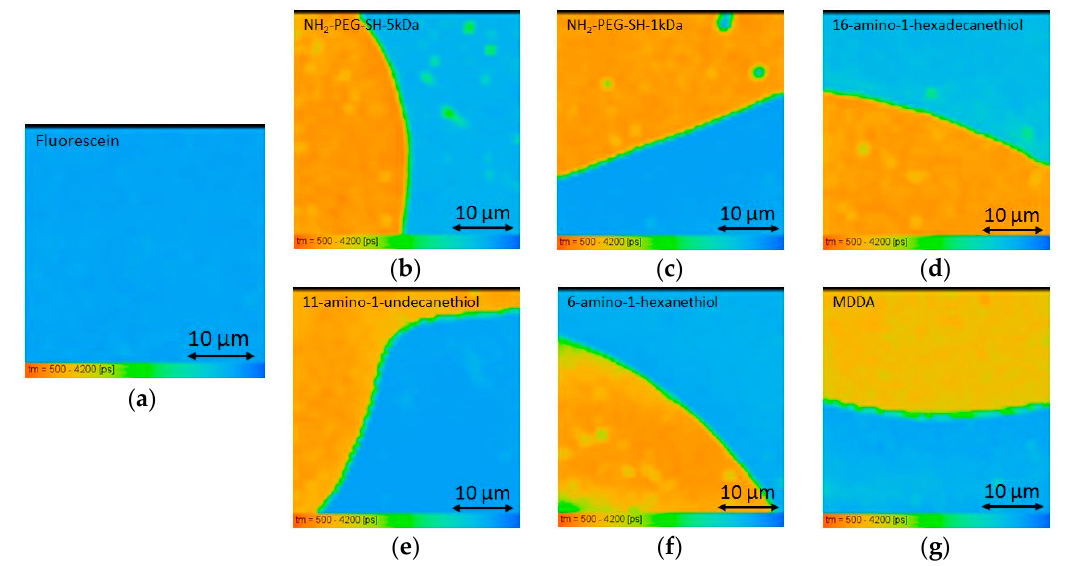
Figure 6. FLIM images of ( a ) free fluorescein control phantom, and the image of the interface region of base phantoms containing free fluorescein (fluorescein concentration of 330 nM) and phantoms containing fluorescein-conjugated-GNRs with conjugation through different likers: ( b ) NH 2 -PEG-SH-5 kDa; ( c ) NH 2 -PEG-SH-1 kDa; ( d ) 16-amino-1-hexadecanethiol; ( e ) 11-amino-1-undecanethiol; ( f ) 6-amino-1-hexanethiol; ( g ) MDDA (Au concentration 0.05 mg/mL, fluorescein concentration of 330 nM). Color indicates the average FLT in each pixel.